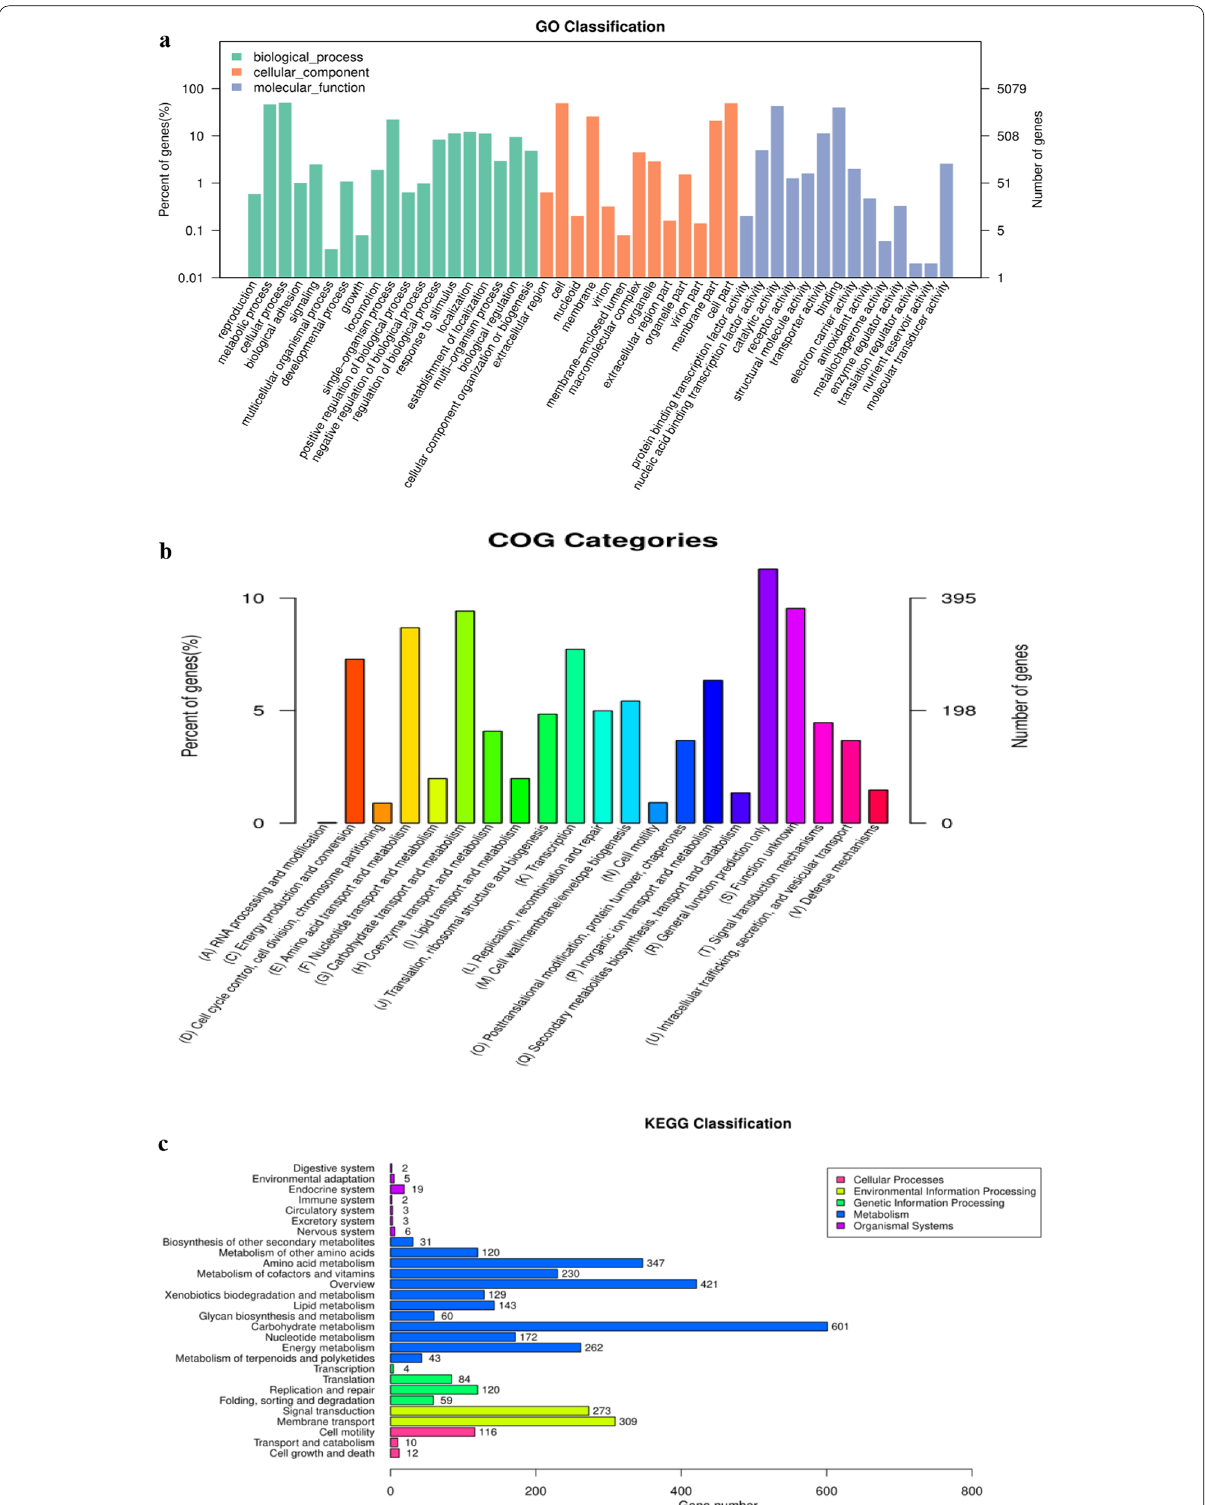
Fig. 3 a The map of GOclassification annotation. b The map of COG classification annotation. c KEGG pathway classification